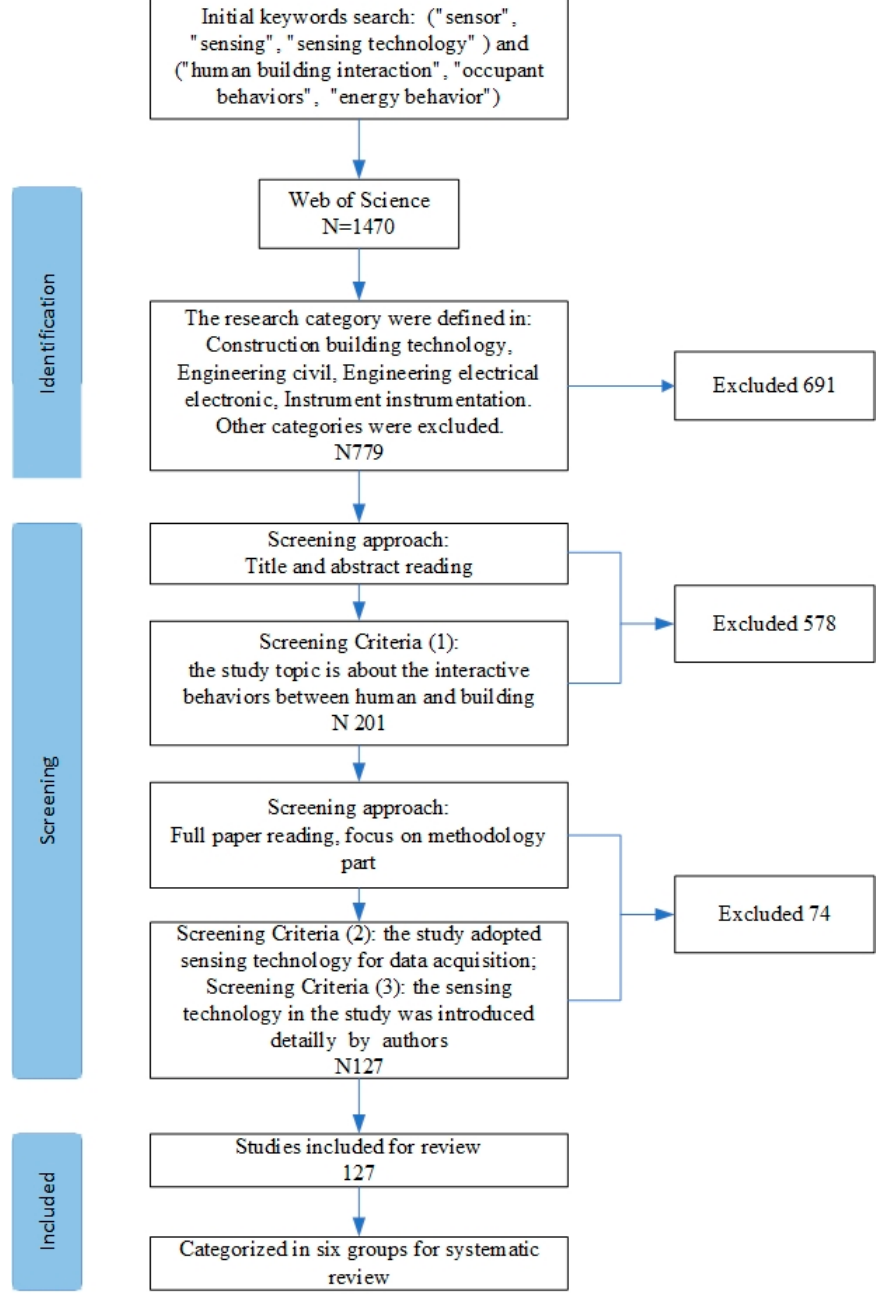
Figure 1. Systematic review process using PRISMA diagram.